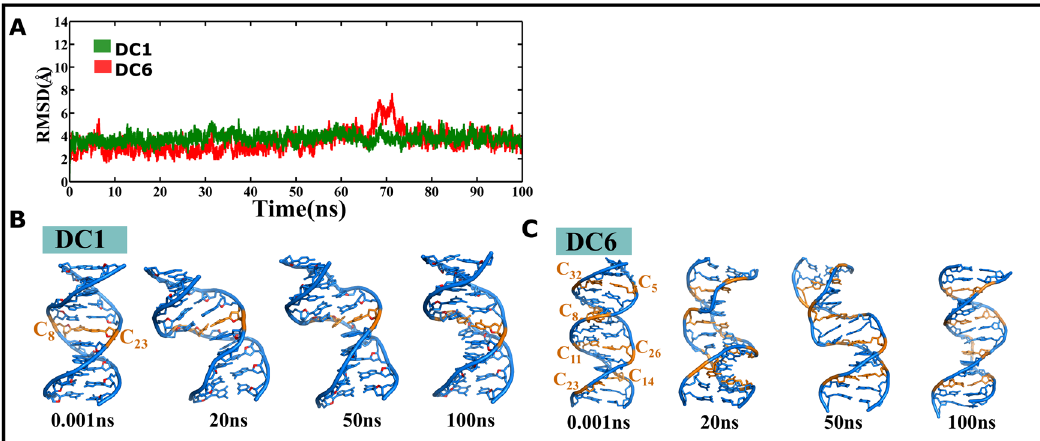
Figure 4. CCG DNA duplexes that contain 1 and 6 C…C mismatches are quite stable. ( A ) Time vs. RMSD profile corresponding to DNA duplexes that have one (green color) and six (red color) C…C mismatches. The MATLAB 7.11.0 software (www. mathw orks. com) was used to plot the data. Note that the lower RMSD value of 4 Å indicates the stable nature of the duplexes. Snapshots corresponding to DNA duplexes that contain ( B ) one and ( C ) six C…C mismatches. This figure was generated by using pymol 1.3 (www. pymol. CCG repeat containing DNA duplex retains the B-form geometry irrespective of the number of C…C mismatches. The DNA duplexes that consist of 1 (DC1) and 6 (DC6) C…C mismatches, respectively, show stable B-form geometry over the 100 ns simulations. The RMSD value calculated with respect to the initial model stays ~ 4 Å during the entire simulation (Fig. 4A). This indicates that the B-form geometry is retained throughout the simulation (Fig. 4B,C). In addition, a 500 ns MD simulation have been carried out using a differ- ent DNA AMBER force fields 35,37 also shows that DC6 (6 C…C mismatches) can be tolerated in the CCG DNA duplex (Supplementary Fig. S7B,D) in contrast to the isosequential RNA duplex (Fig. 2B), wherein the C…C mismatches above 4 distort the A-form geometry. Preponderance of duplex/hairpin conformation by d(CCG) and i-motif conformational inter - mediates by r(CCG). In line with the MD simulations, the CD spectra corresponding to DC6 (6 C…C mismatches) also supports the formation of B-form geometry with a positive peak around ~ 285 nm and a negative peak around ~ 260 nm, irrespective of pH (pH 3, 4, 5, 6, 7, 8, and 9) (Fig. 5A). Additionally, the salt- dependent CD spectra do not show any B to Z transition under various concentrations of NaCl (0.05 M NaCl and 4.2 M NaCl) (Fig. 5B). These indicate the preference for B-form duplex by DC6. The RNA duplex containing 6 C…C mismatches (RC6) forms an i-motif/i-motif conformational intermediate structure with a positive and a negative signature peaks at ~ 285 nm and ~ 255 nm respectively, irrespective of the pH (3, 7, and 9) (Fig. 5C). However, the RC5 scheme that has 5 C…C mismatches shows a positive peak at ~ 275 nm and a negative peak at ~ 210 nm at different pH values (3, 7, and 9). In addition, a peak broadening is observed for RC5 between 230 and 250 nm for pH values in the range of pH 3.0 and pH 9.0 (Fig. 5D). Although the negative signature peak around 210 nm indicates the presence of the A-form conformation, peak broadening may reflect the presence of both i-motif and A-form conformations. Thus, RC5 may adopt an intermediate conformation that has the features of both A-form and i-motif geometries. However, the differences in CD spectra of RC5 and RC6 indi- cate that the RNA conformations may be different between the two cases. In contrast, CD spectra associated with the RC1 sequence (containing a single C…C mismatch) show a positive and negative peaks at ~ 275 nm and ~ 210 nm, respectively, representing the formation of A-form RNA duplex at different pH values (3, 7, and 9) (Fig. 5E). Thus, it is clear that the number of C…C mismatches is the deciding factor for the preference of the A-form duplex or i-motif/i-motif like conformation by r(CCG). The CD spectra of DNA sequence with canonical base pairs (DWCa without C…C mismatches) that pos- sesses the canonical base pairs indicate the presence of B-form conformation at various concentrations of KCl and NaCl. This can be seen by a positive peak at ~ 270 nm and a negative peak at ~ 250 nm (Supplementary Fig. S9A,B). Similarly, RNA with canonical base pairs (RWCa without C…C mismatches) forms an A-form in the presence of KCl and NaCl (Supplementary Fig. S9C,D). Thus, the CD results support the MD observations. To further support our CD and MD results, we have carried out EMSA for both DNA (DC5 & DC6) and RNA (RC1, RC5, and RC6) sequences. The results reveal that DC6 (lane 4) and DC5 (lane 5) migrate faster than the single-stranded d(T) 18 (lane 1), d(T) 15 (lane 2), and d(T) 10 (lane 3), which is indicative of the formation of an intramolecular-folded conformation at pH 5 (Fig. 5F (left)), 7 (Fig. 5F (middle)), and 9 (Fig. 5F (right)). As the CD spectra corresponding to DC6 (Fig. 5A) and DC5 (Supplementary Fig. S10) at pH 5, 7, and 9 represent the B-form geometry, the conformations observed at pH 5, 7, and 9 in EMSA may correspond to a hairpin. How- ever, smeared bands at pH 5 may correspond to a minor population of other conformations, such as i-motif or i-motif-like conformations 38 . Notably, the extent of smear is more at pH 5 compared with the pH 7 and pH 9. The C…C mismatch in the hairpin may be stabilized by the N4…N3 hydrogen bond at pH 7 and pH 9, whereas